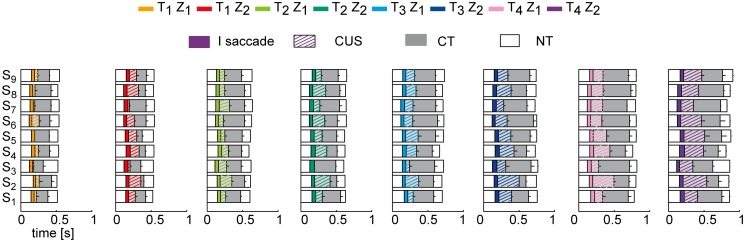
Eye movement event timeline for each subject averaged across trials in all the experimental conditions.Distribution of the eye movement events for each subjects (rows) averaged across trials of each experimental condition (mean ± SE; SE represent by the black lines inside the bars). The different T-Z conditions are reported in different columns. Colored bars represent the average duration of the first saccadic movement; striped colored bars represent the average CUS duration. Gray bars represent the average CT duration. White bars at the beginning and at the end of the raster plots represent respectively the latency time LTs and the NT interval.